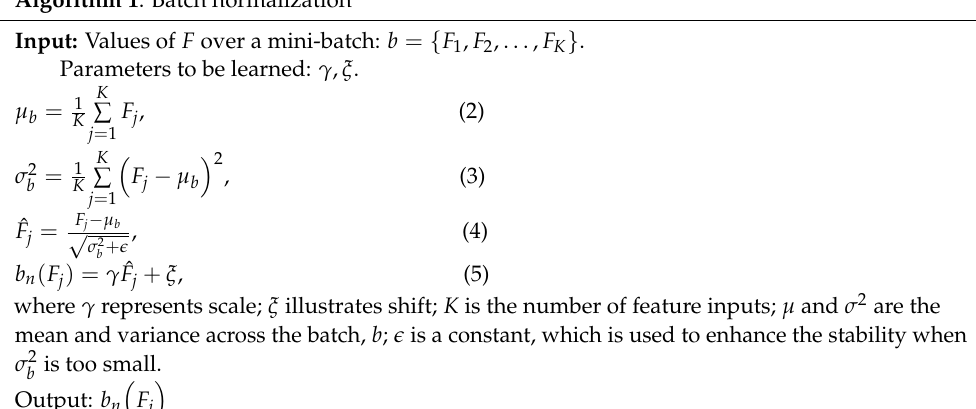
Algorithm 1 . Batch normalization